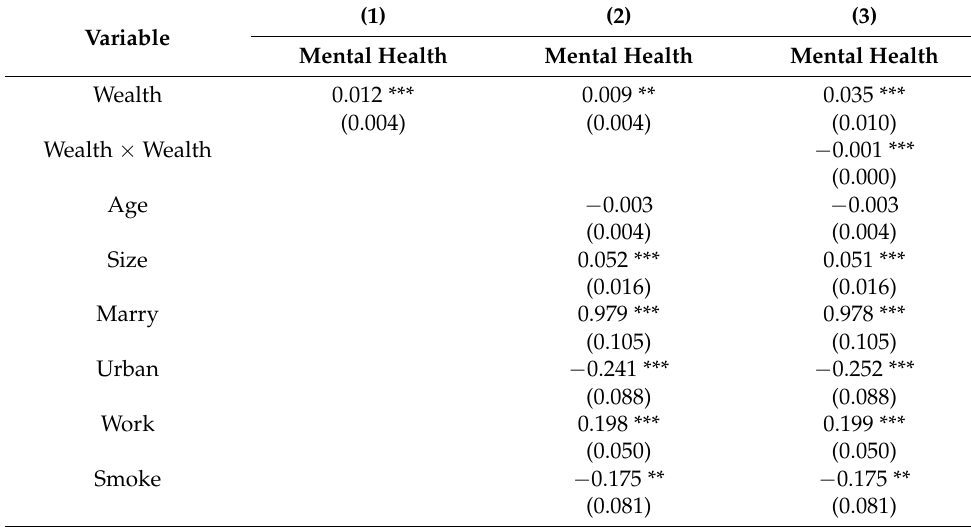
Table 2. Baseline estimation